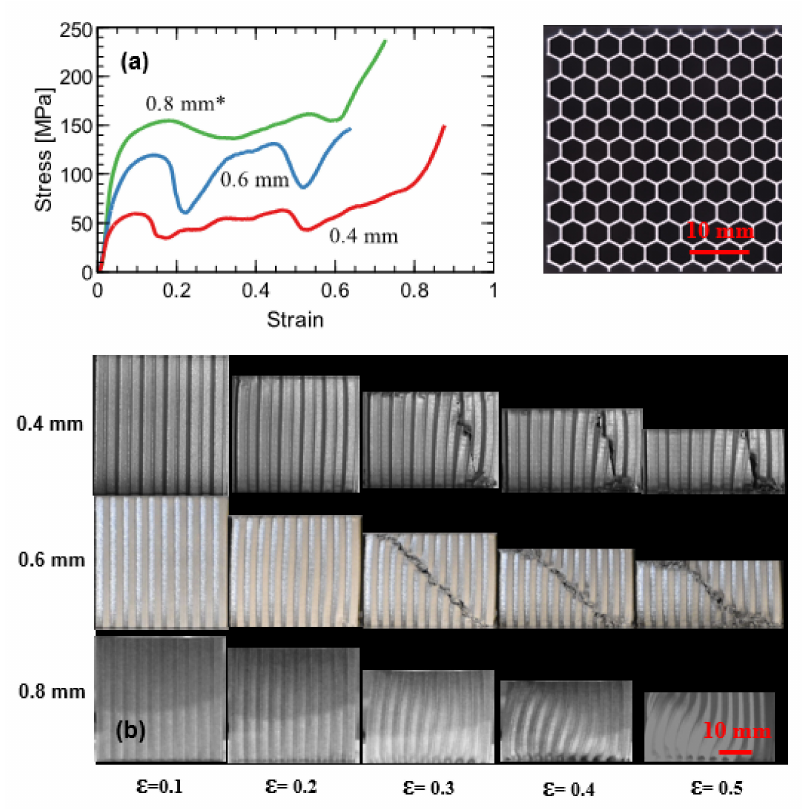
Figure 6. ( a ) Stress–strain curves for honeycomb compression with 0.4-, 0.6- and 0.8-mm thickness (* the 0.8-mm specimen was tested on a different mechanical load frame), ( b ) honeycomb deformation for each of the three thicknesses at increasing strain.